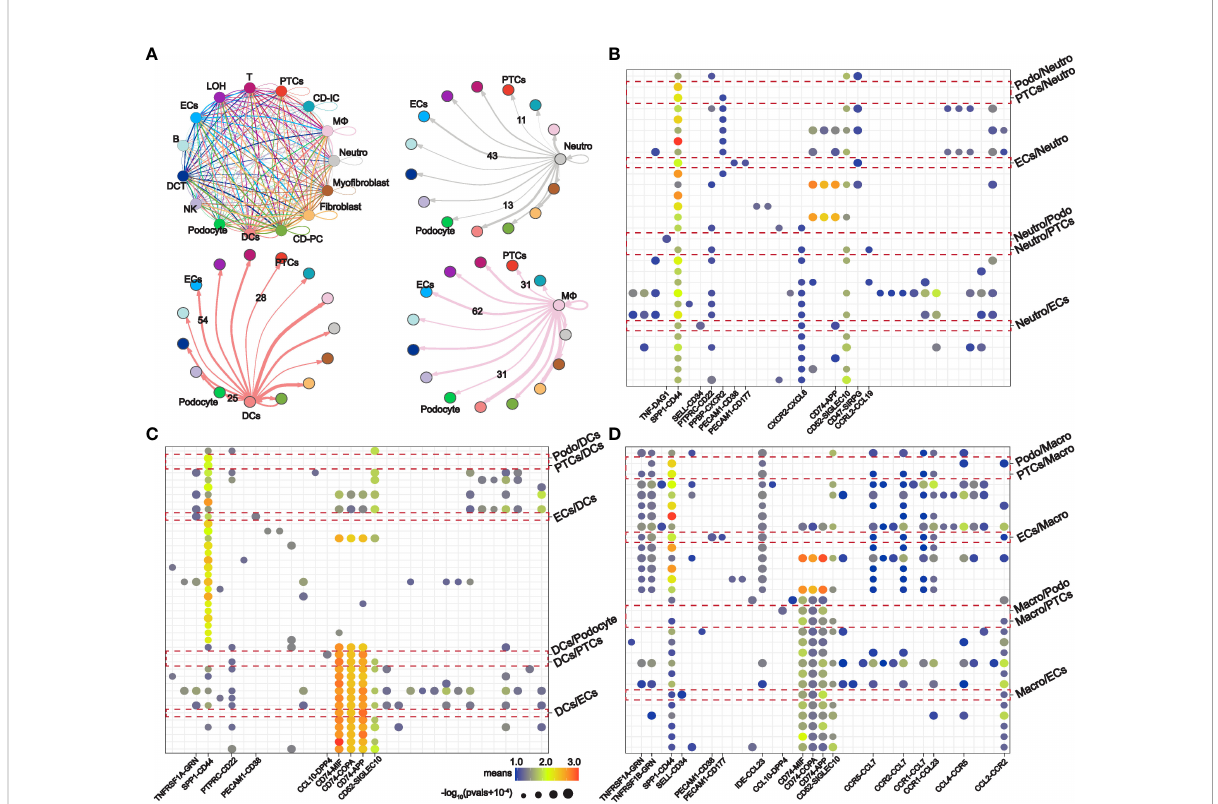
FIGURE 6 Intercellular ligand-receptor analysis explores potential renal immune cell-parenchymal cell interactions in COVID-19 kidney injury. (A) Ligand- receptor interaction network between speci fi c renal immune cells (neutrophils, macrophages, and dendritic cells) and parenchymal cells (proximal tubule cells, podocytes, and endothelial cells). (B – D) Expression of immunostimulatory and chemokine-related ligand receptors between speci fi c renal immune cells and parenchymal